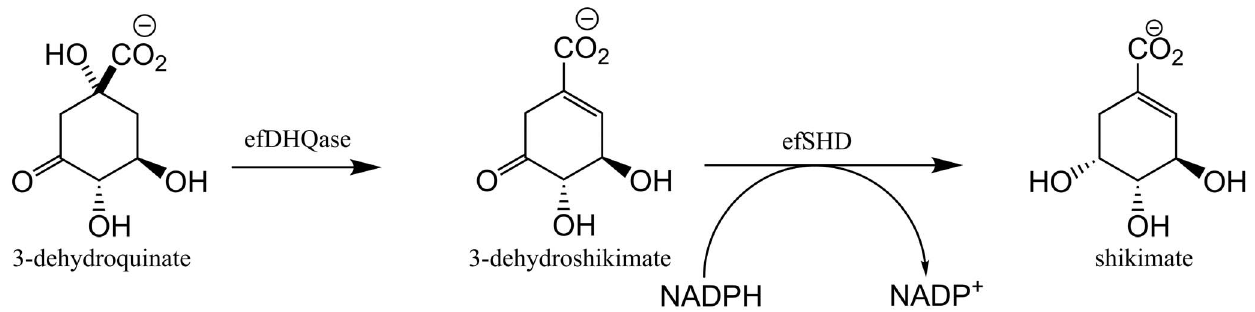
Figure 3. efDHQase-efSHD coupled-enzyme assay. doi:10.1371/journal.pone.0103598.g003 PLOS ONE |